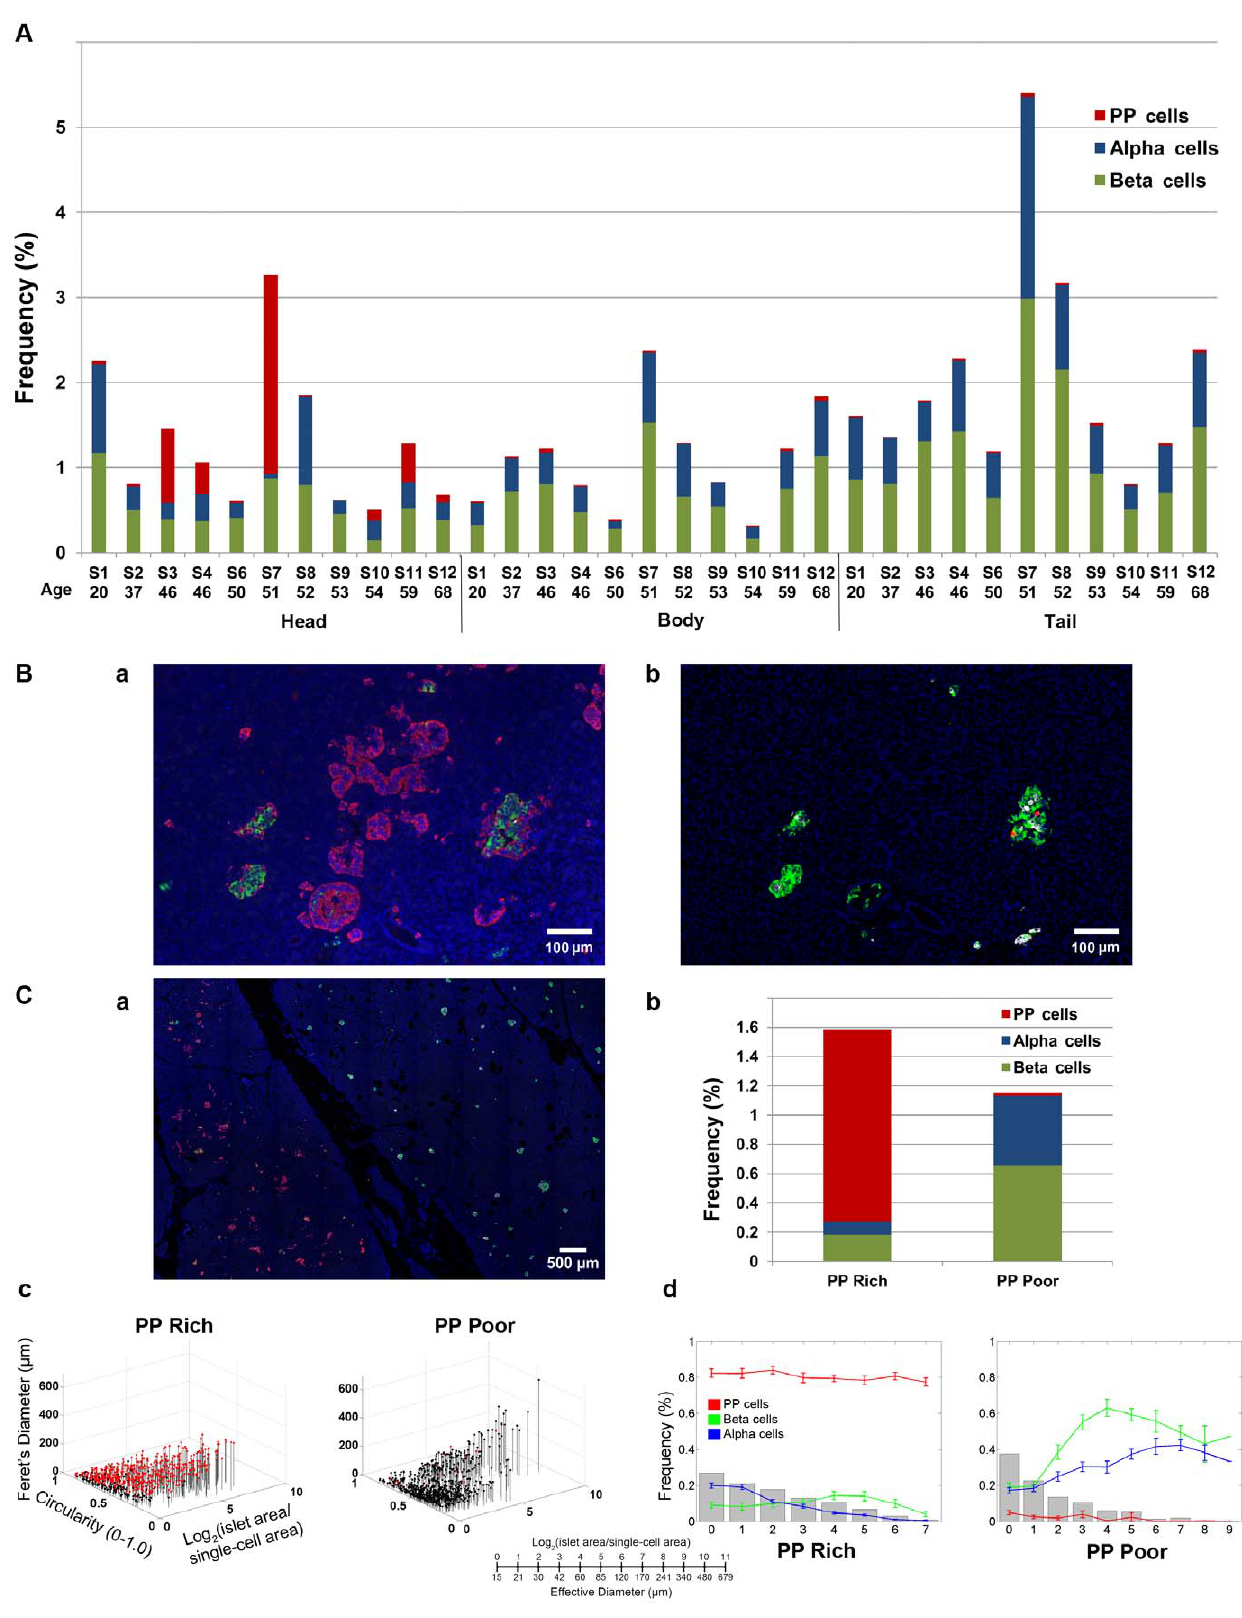
Figure 3. Analysis on multiple specimens. A : Inter-specimen comparison of endocrine cell mass in the head, body and tail region. B : a . Representative view of islets in the PP-cell rich area (PP in red, insulin in green, glucagon in white and nuclei in blue). b . Adjacent section immunostained for insulin (green), glucagon (red), somatostatin (white) and nuclei (blue). C : Intraspecimen comparison of the PP-cell rich and poor